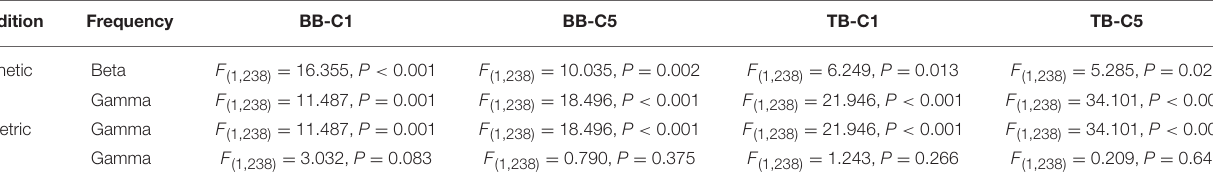
TABLE 2 | Results of one-way ANOVA on the CMC sig value of the flexion and extension stages according different conditions and frequency.